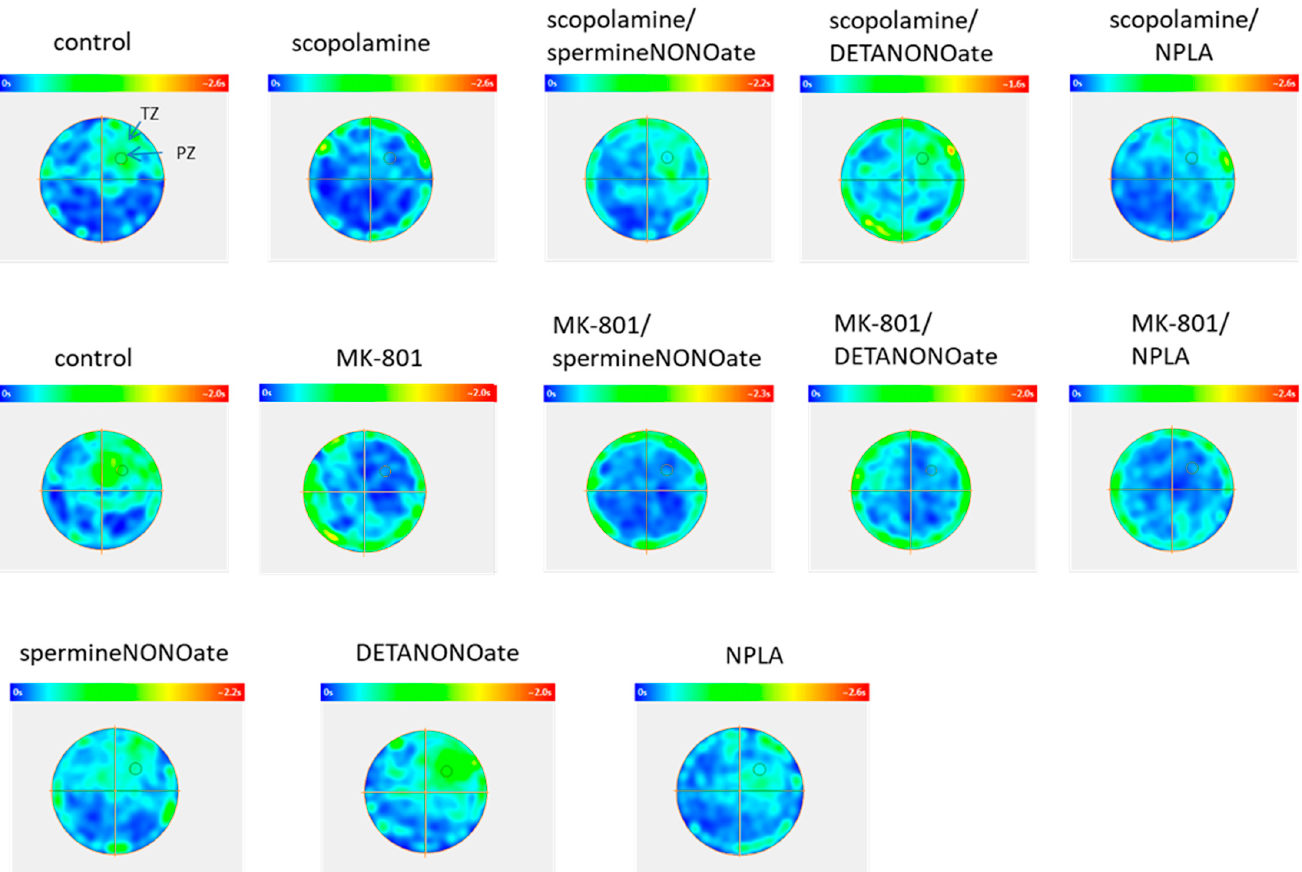
Figure 15. Heat maps reflecting the time spent swimming in particular areas of the maze. The maps show mean data for different treatment groups. Dark blue—no time spent in the area, red—the most time spent in the area. TZ—target zone; PZ—platform zone.